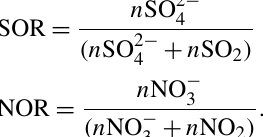
, and (e) SO 2 − for the whole S3 period. The location of the monitoring site is marked 3 4